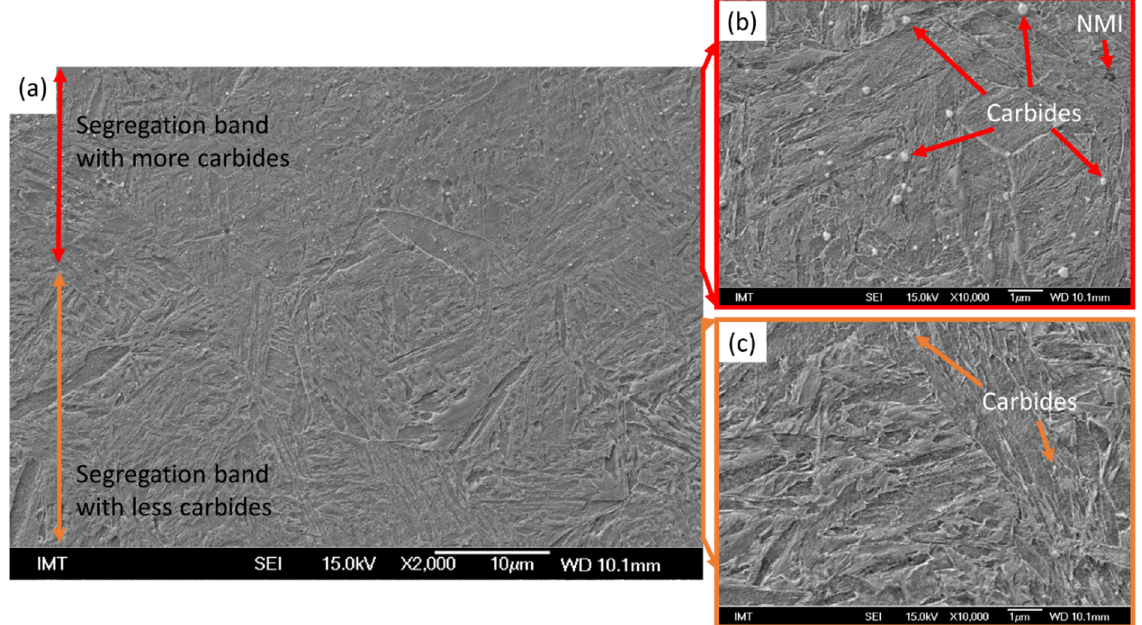
Figure 13. ( a ) SEM images of quenched 1040 °C ‐ 30 min sample at lower magnification, ( b ) segrega ‐ tion band, ( c ) area with less segregations. Notes: NMI—non ‐ metallic